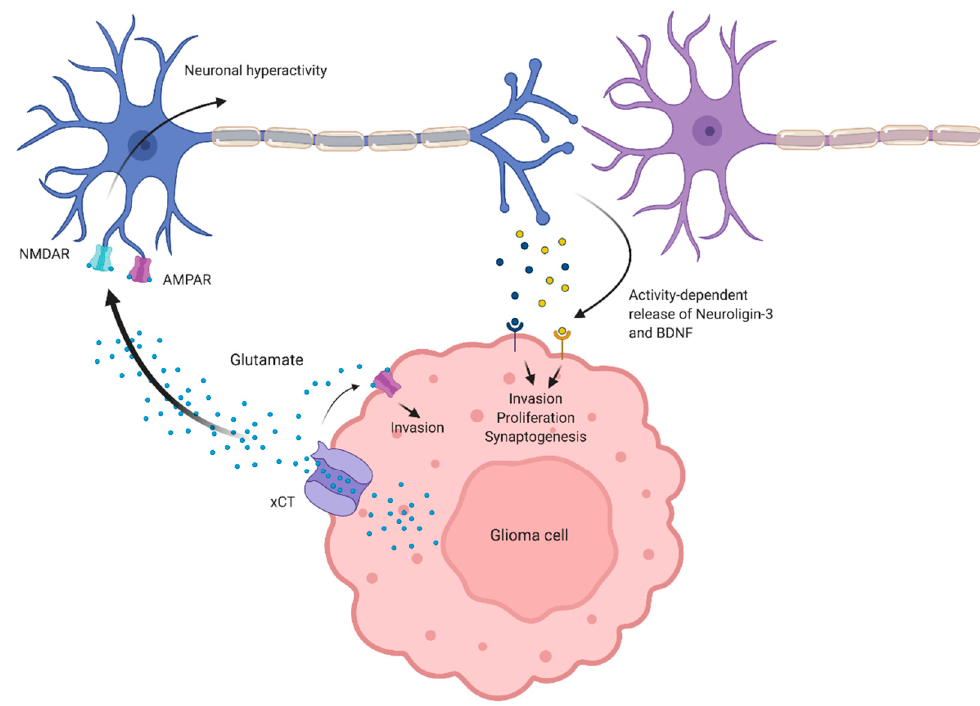
Figure 1. Effects of aberrant glutamate levels in the tumor microenvironment. Glioma-derived glutamate activates α -amino-3-hydroxy-5-methyl-4-isoxazolepropionic acid receptors (AMPARs) on glioma cells to drive invasion. Glutamate also induces cortical hyperexcitability, presumably via activation of AMPARs and N-methyl-D-aspartate receptors (NMDARs) on peritumoral neurons. Neuronal hyperactivity mediates the release of presynaptic proteins, such as brain-derived neurotrophic factor (BDNF) and Neuroligin-3, which drive glioma proliferation, invasion, and synaptogenesis between glioma cells and peritumoral neurons.